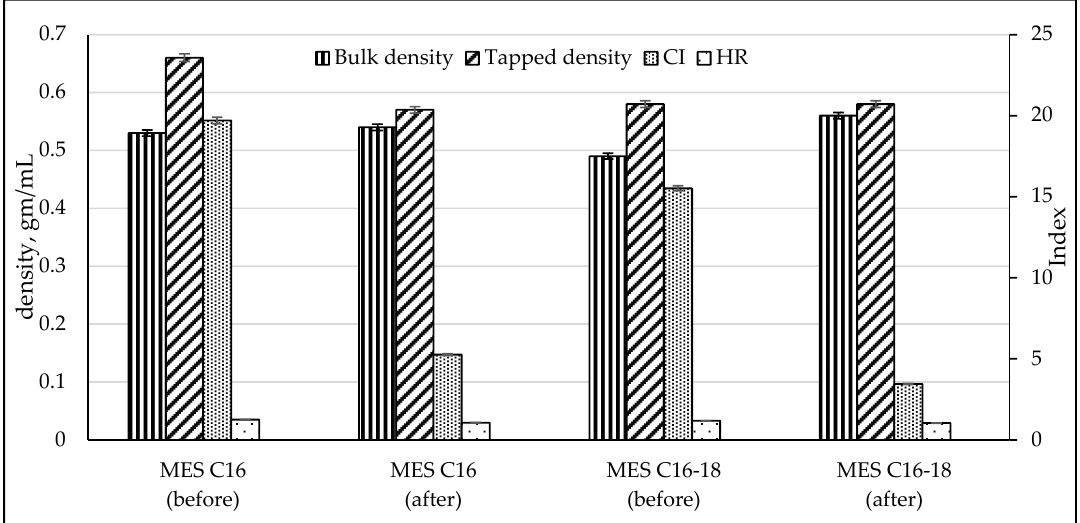
Figure 7. The bulk and tapped density of palm stearin-based MES (C 16 and C 16-18 ) before and after repeated recrystallization.